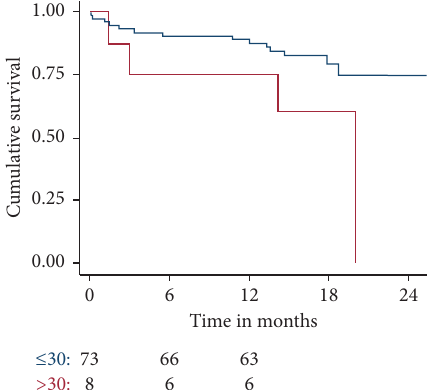
Figure 3: Cumulative survival of patients with postprocedural c- reactive protein (pCRP) > 30 vs. ≤ 30mg/dl. Patients with pCRP > 30mg/dl had a worse outcome. PCRP > 30mg/dl was a significant predictor of mortality ( p �